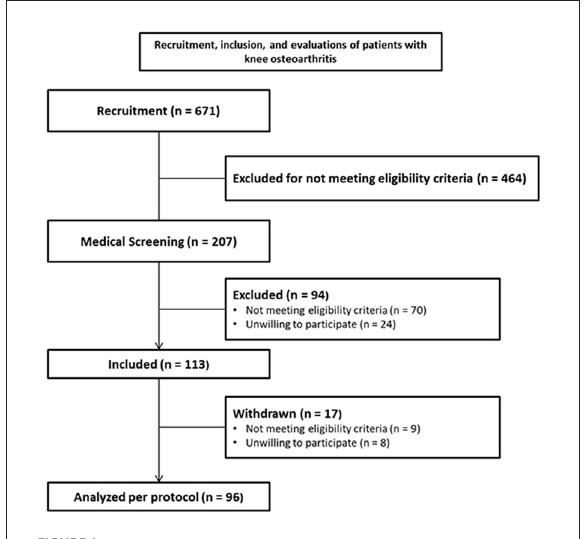
FIGURE1 Description of patients with knee osteoarthritis (OA) were recruited and included in the present study.